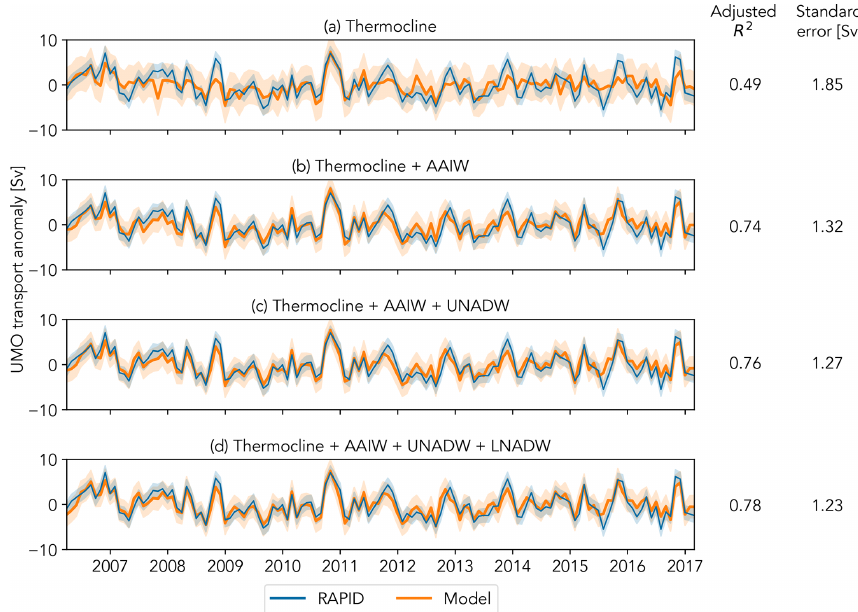
Figure 3. Comparison of UMO transport anomaly predicted by GLSAR(1) regression models using one to four layers with the UMO transport anomaly observed by RAPID. The layers represented by the regression-independent variables are shown above each plot, and the model R 2 value, adjusted for the degrees of freedom of each model, and standard error of the regression are shown to the right. The orange shading around each model prediction line shows the 95% prediction interval. The blue shading around the observed transport shows the 1.5Sv uncertainty estimated by McCarthy et al.